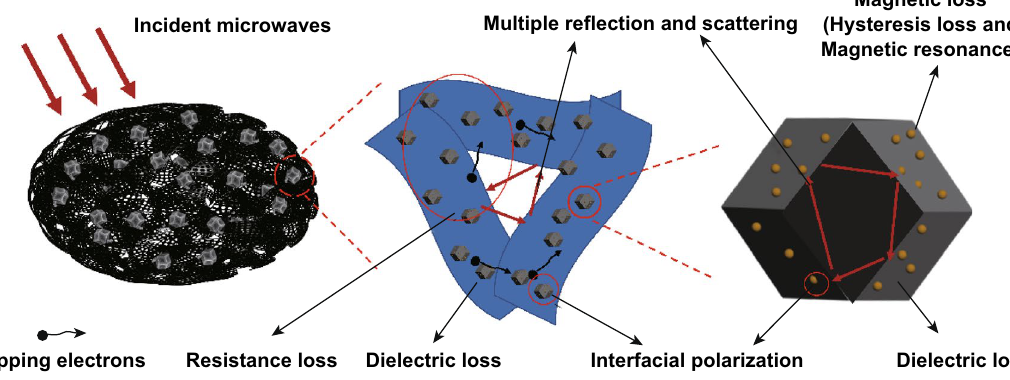
Fig. 12 Schematic diagram of microwave absorption mechanism of